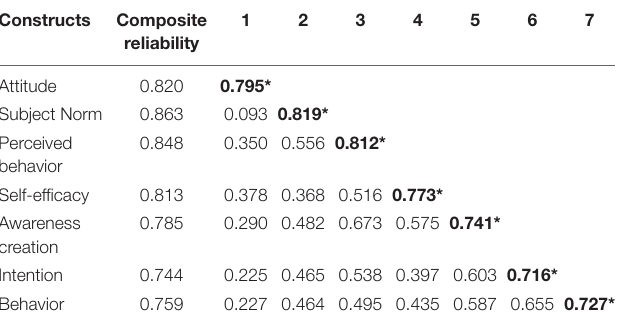
TABLE 4 | The average variance extraction of constructs. Constructs